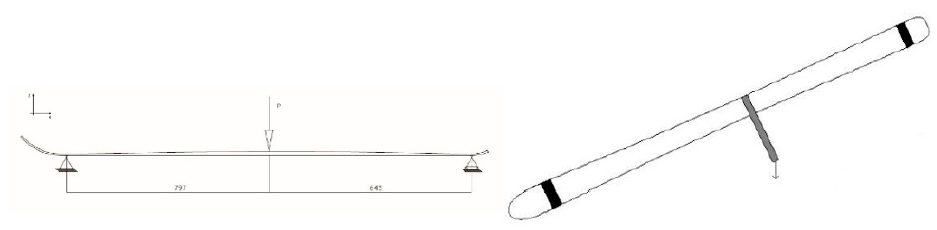
Figure 3. Schematic representation of the three-point bending and torsion-bending tests—reference case for the FE simulations .